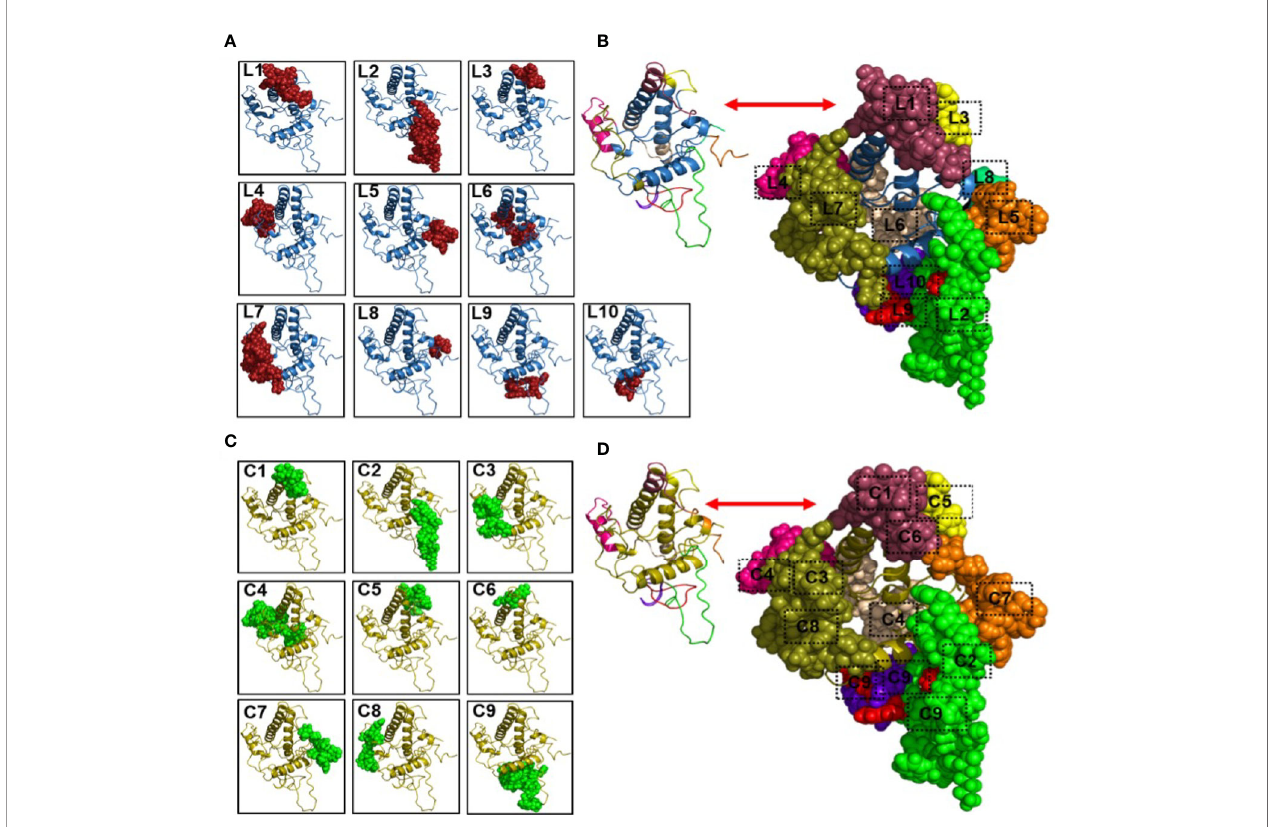
FIGURE 2 | Predicted linear and conformational B cell epitopes and their position in the human major prion protein structure. Here, the protein structures have shown as cartoon structure and the linear and conformational B cell epitopes have shown as spheres on the protein structures. (A) Linear B cell epitopes where L1 (222-238), L2 (89-111), L3 (167-174), L4 (137-153), L5 (245-253), L6 (189-204), L7 (24-49), L8 (1-4), L9 (56-66), and L10 (76-86) representing different epitope position. (B) all the linear B cell epitopes have been shown as spheres by different colours to see the overlaps of the identi fi ed linear B cell epitopes. (C) Conformational B cell epitopes where C1(227-235), C2 (100-112), C3 (25-38), C4 (137-149, 151-153, 157, 189, 191-204), C5 (164, 168-174, 177), C6 (222-225), C7 (236-238, 242, 245-253), C8 (39-49), and C9 (55-67, 75-86, 89-99) representing different epitope position. (D) all the conformational B cell epitopes have been shown as spheres by different colours to see the overlaps of the identi fi ed conformational B cell epitopes. Here, liner B cell epitope L1 was found in the conformational B cell epitope position C1 and C6; C2 and C9 representing the linear epitope L2; C5 representing the linear epitope L3; C4 (two position where one is in the left side and the other one is in the middle position of the structure) representing the linear epitope L4 and L6; C7 representing the linear epitope C5; C3 and C8 representing the linear epitope L7; and the conformational epitope C9 (two position in the bottom of structure) representing both the linear epitope L9 and L10.